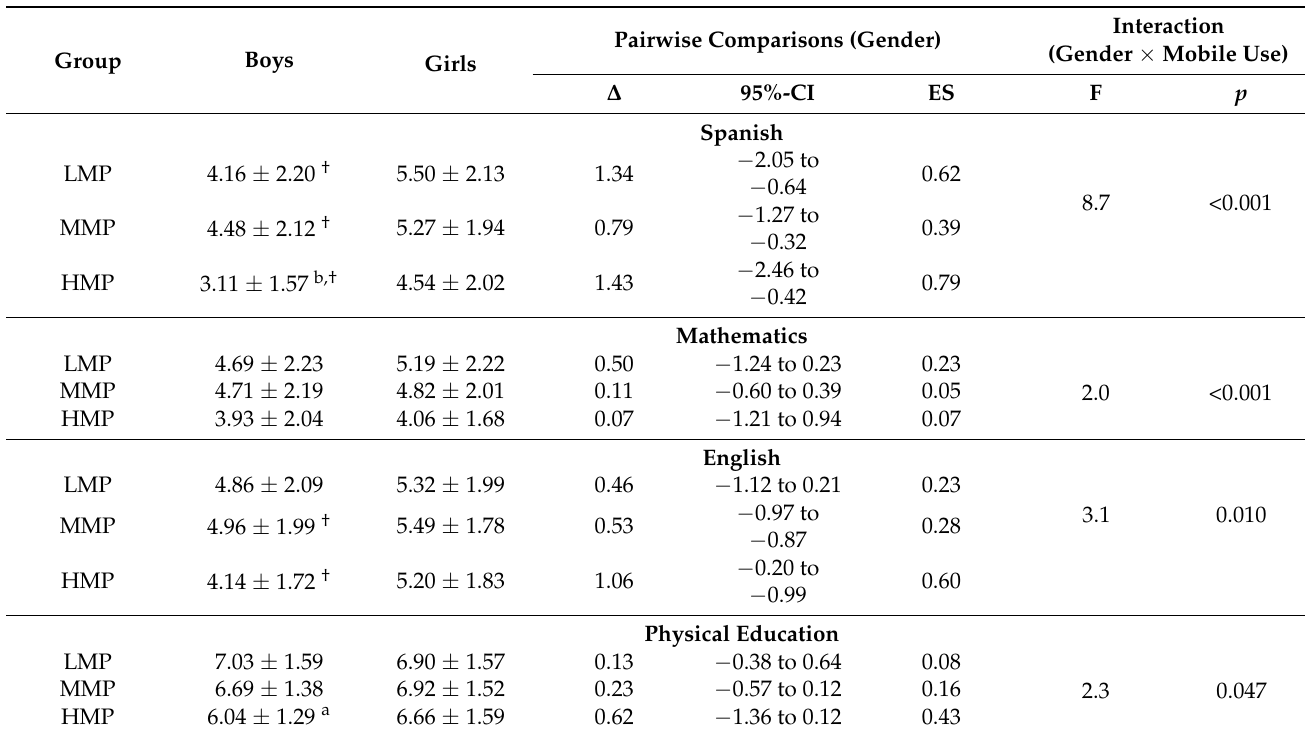
Table 2. Results of academic variables.